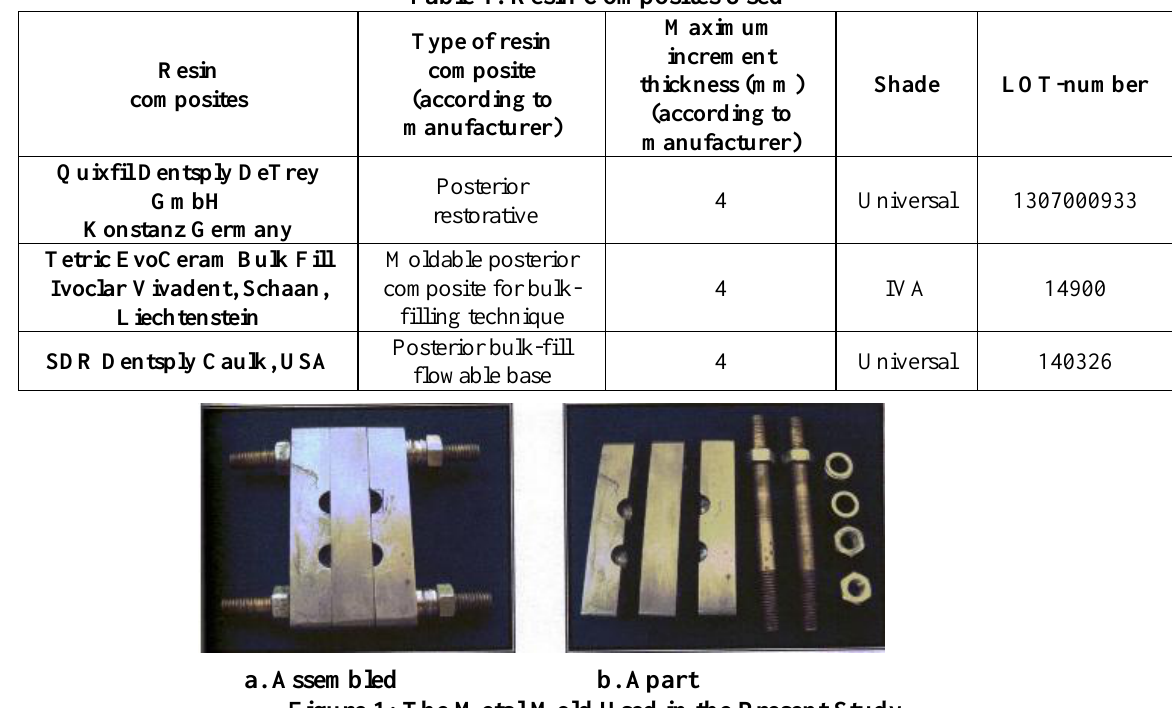
Table 1: Resin Composites Used